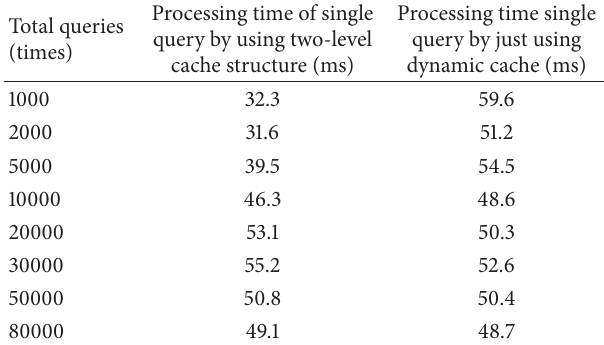
Table 1: The processing time of single query.